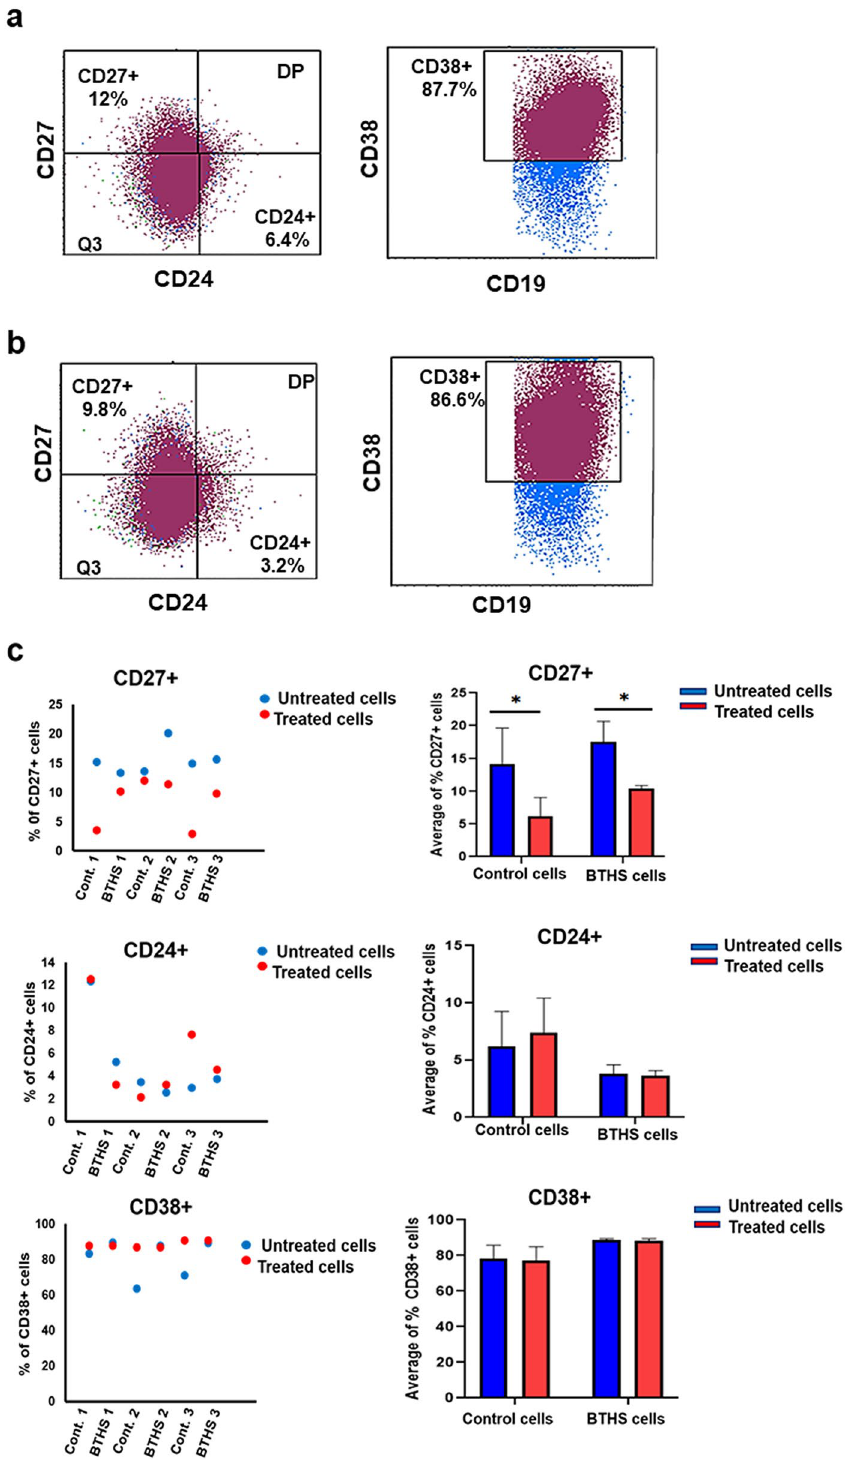
Figure 4. Epstein-Barr virus transformed human age-matched control and BTHS B lymphoblasts show variable expression of CD27 + , CD24 + , and CD38 + surface markers upon CpG DNA stimulation. The expression of CD27 + , CD24 + , and CD38 + surface markers was determined in control and BTHS cells after stimulation without or with 5 µM CpG DNA using flow cytometry as described in “Materials and Methods”. ( a ) Representative flow cytometry images of CD27 + , CD24 + , and CD38 + surface markers in control cells after CpG DNA stimulation. ( b ) Representative flow cytometry images of CD27 + , CD24 + , and CD38 + surface markers in BTHS cells after CpG DNA stimulation. ( c ) Histograms showing percentage of CD27 + , CD24 + , and CD38 + surface marker expression in CpG DNA treated control and BTHS cells compared to untreated control and BTHS cells. N = 3, * p <